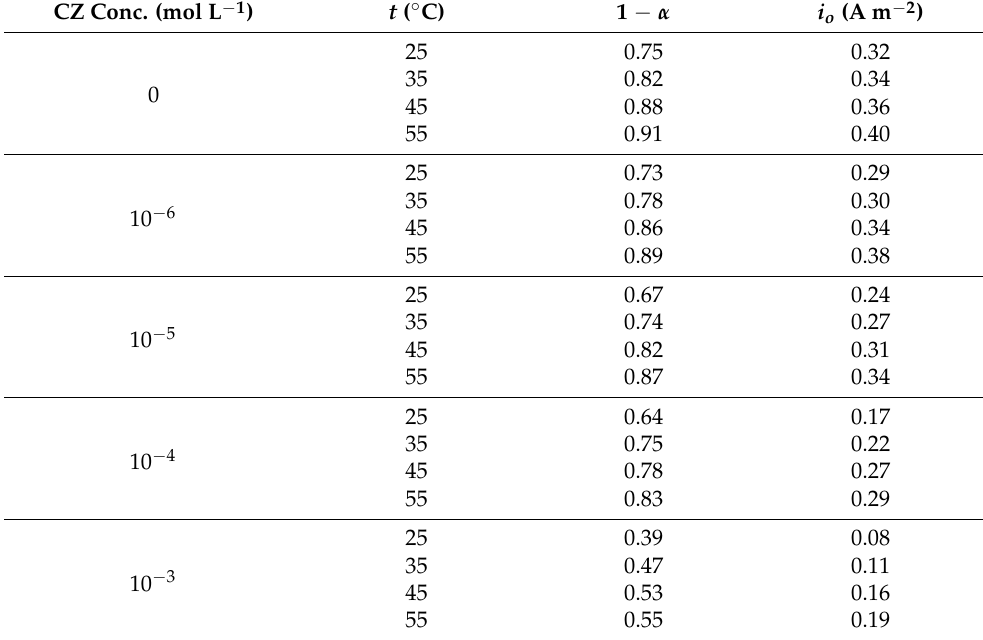
Table 1. Kinetic parameters for copper deposition from 5 g L − 1 Cu 2+ without and with different concentrations of CZ, in 25–55 ◦ C temperature range.